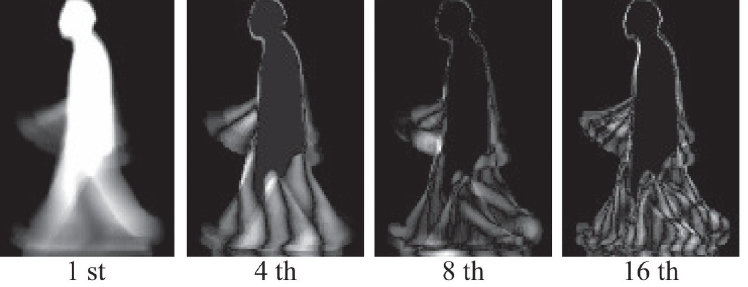
Fig 3. Visualizations of eigenvectors ϕ c (1st, 4th, 8th, and 16th) of MSM. The image of the first principal component is similar to